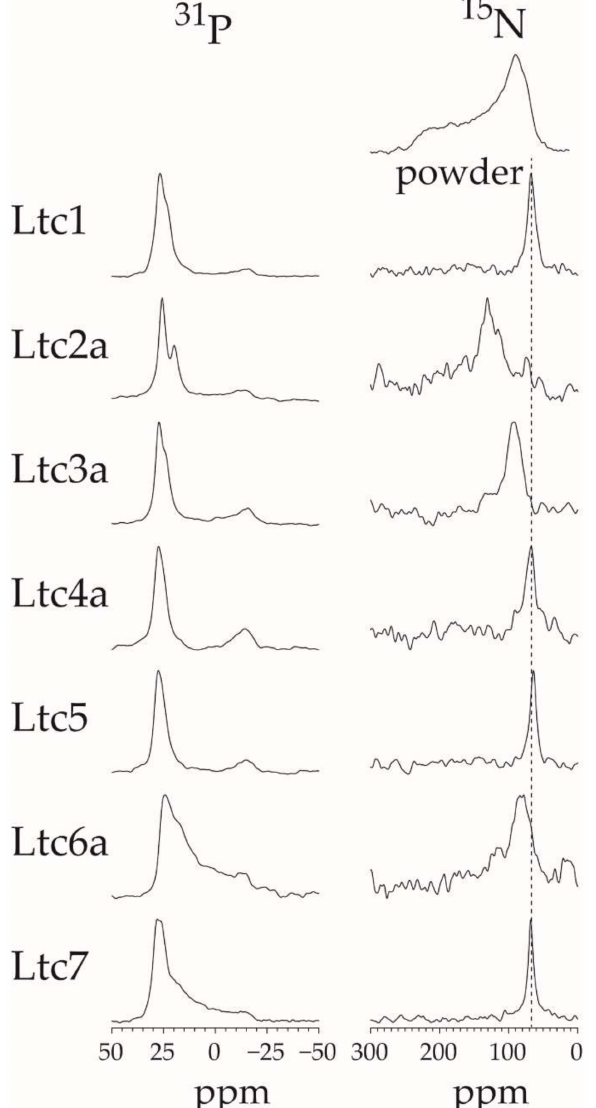
Figure 7. Solid-state NMR of 15 N-labeled latarcin peptides in oriented samples of DMPC/DMPG (7/3), showing 31 P-NMR of the phospholipids on the left and 15 N-NMR of the peptides on the right. The 31 P peak close to 28 ppm corresponds to oriented lipids, whereas the broad distribution and the peak around − 15 ppm come from unoriented lipids. The 15 N-NMR powder spectrum at the top encompasses the entire range of chemical shifts: an oriented signal as 65 ppm (black dotted line) indicates that a peptide lies flat on the membrane surface; higher ppm values indicate that the helix is slightly tilted in the membrane, while 180 ppm indicates an upright transmembrane alignment (not seen